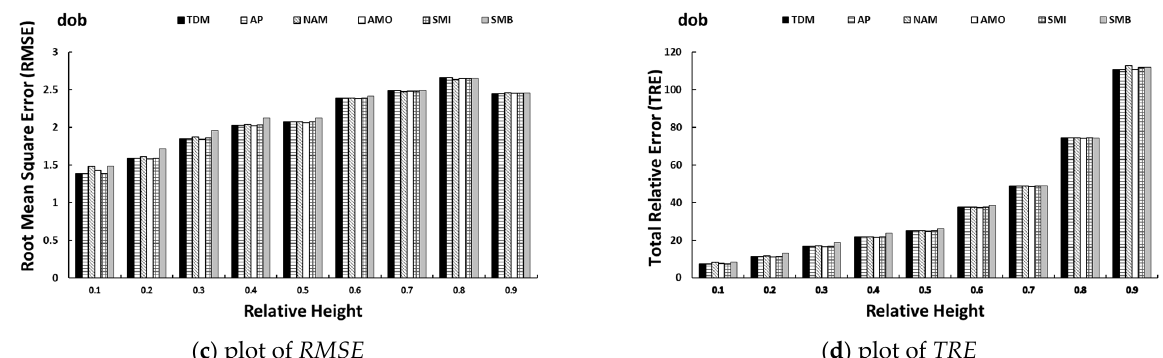
Figure 3. Plots of evaluation statistics from six methods against relative height classes for dob.